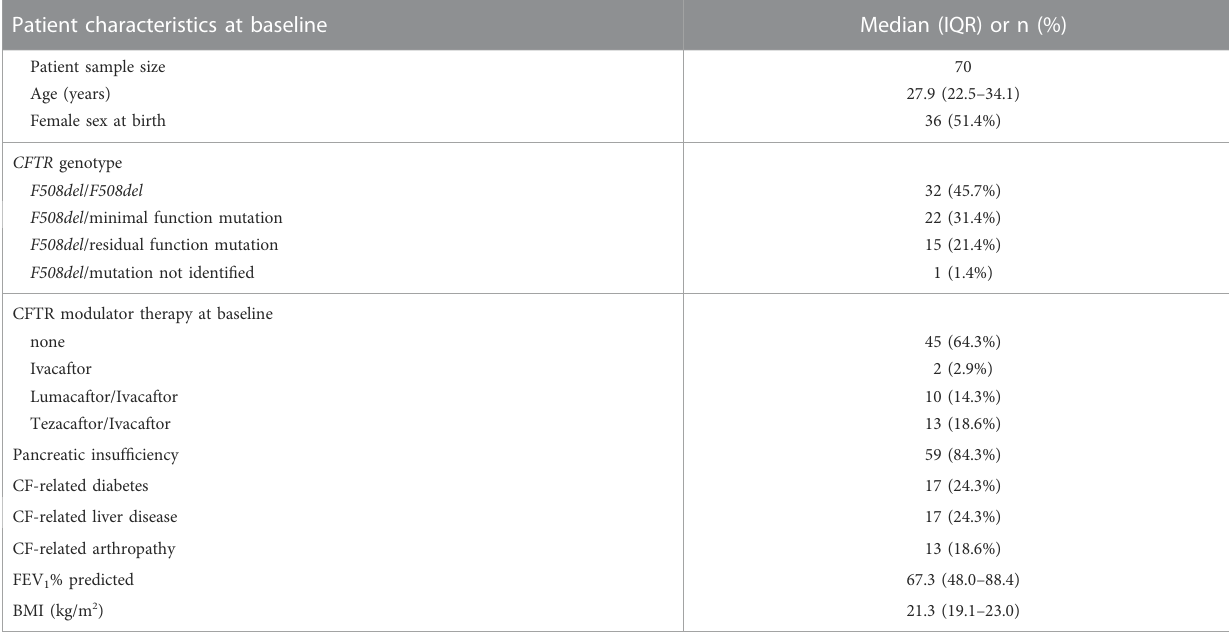
TABLE 1 Clinical characteristics of patients with cystic fi brosis at